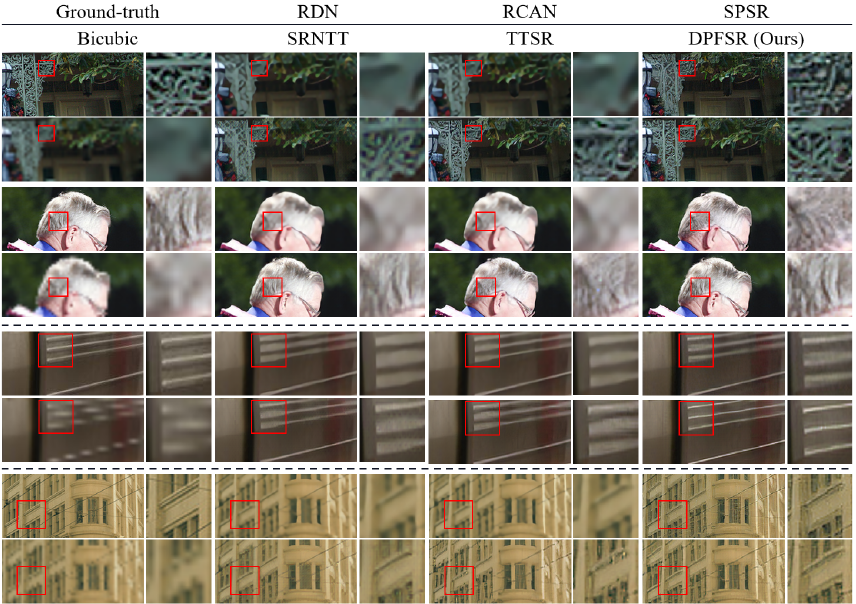
Figure 5. Qualitative comparison with other SR methods on the CUFED5 testing set (the top two examples), Sun80 [43] (the third example), and Urban100 [44] (the bottom example). To see the details of the image clearly, the area marked by the red frame is